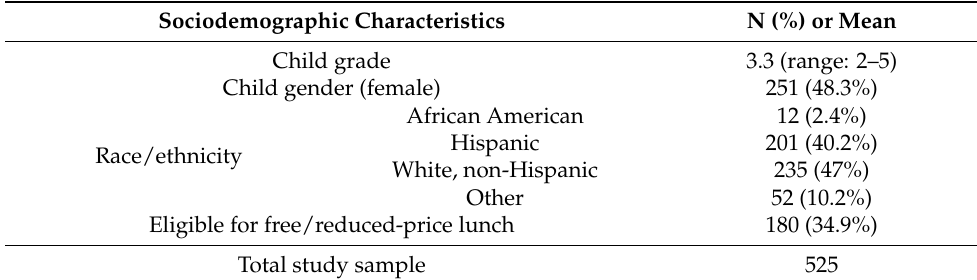
Table 1. Sociodemographic characteristics of the study sample